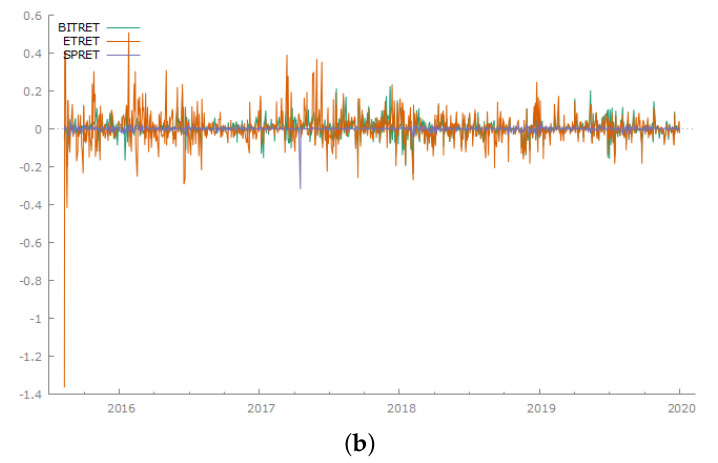
Figure 1. Plots of the series pre-COVID-19. ( a ) Plot price series levels pre-COVID-19. ( b ) Plot of returns pre-COVID-19.